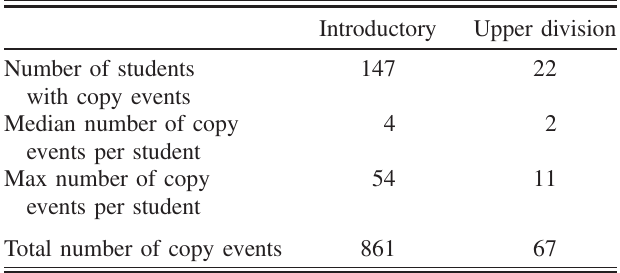
TABLE III. Number of copy events detected in the introductory and upper-division populations. For reference, the total number of valid responses in the introductory and upper-division datasets was N ¼ 1287 and N ¼ 308 , respectively. The CUE, QMCA, FMCE, and BEMA have 16, 38, 47, and 31 questions,